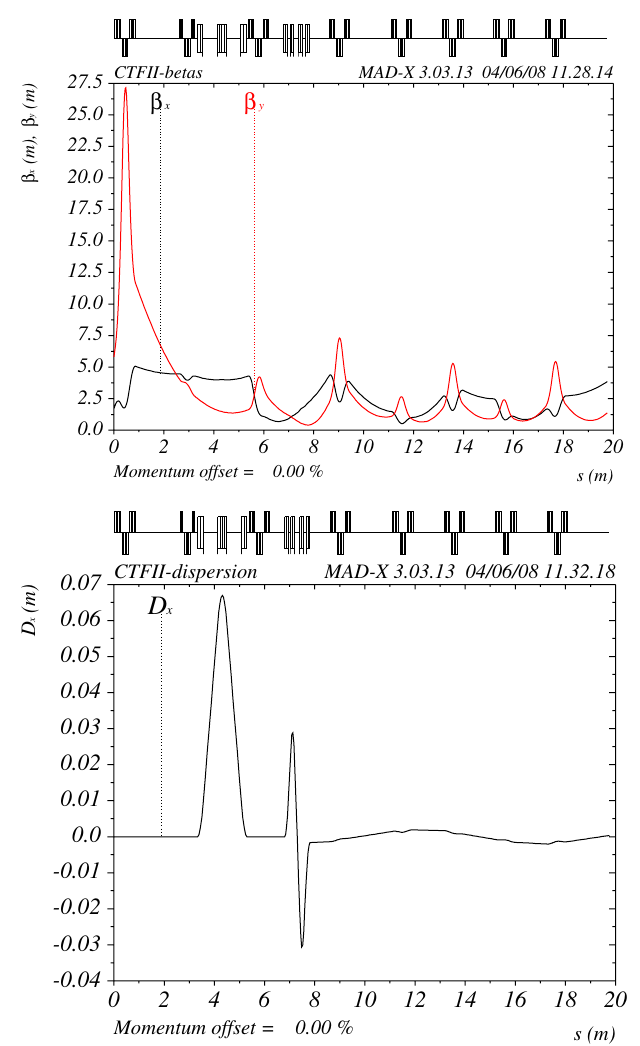
FIG. 1. (Color) Lattice functions for the CTF-II test facility (as reconstructed for (cid:2) x ¼ 4 m for this report.) The lower plot shows the dispersion function with first chicane (the ‘‘compres- ¼ 10 : 5 mm and the second sor chicane’’) powered for R 56 ¼ 19 mm . chicane (the ‘‘shielded chicane’’) powered for R 56 In both cases these are the values that would be obtained at the output with the other chicane turned off. The second chicane is powered off for all data except in Sect. IV F. The (slight) residual dispersion leakage in this plot is due to the shielded